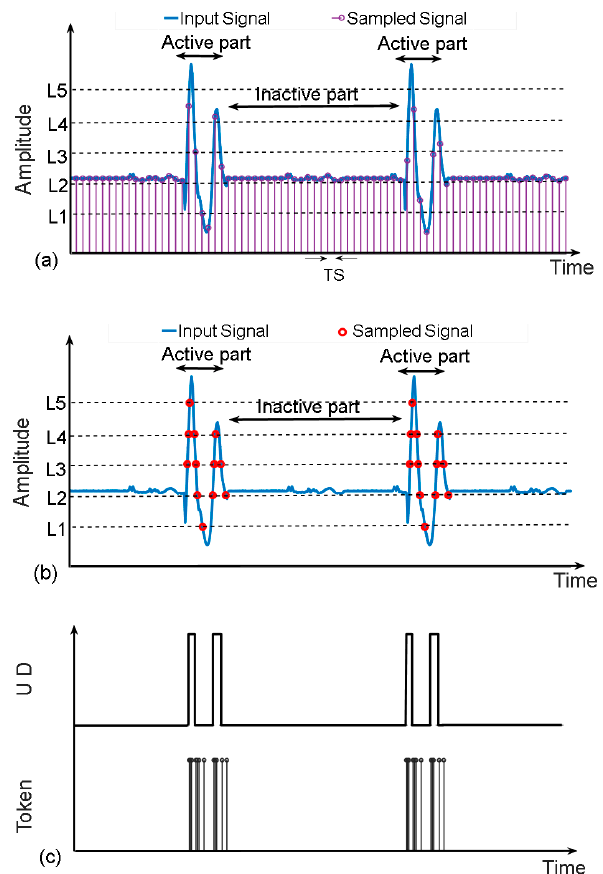
Figure 2. Different sampling schemes: ( a ) uniform sampling, ( b ) level-crossing sampling with K = 2 LSBs, ( c ) level-crossing sampling output signals (UD and Token).